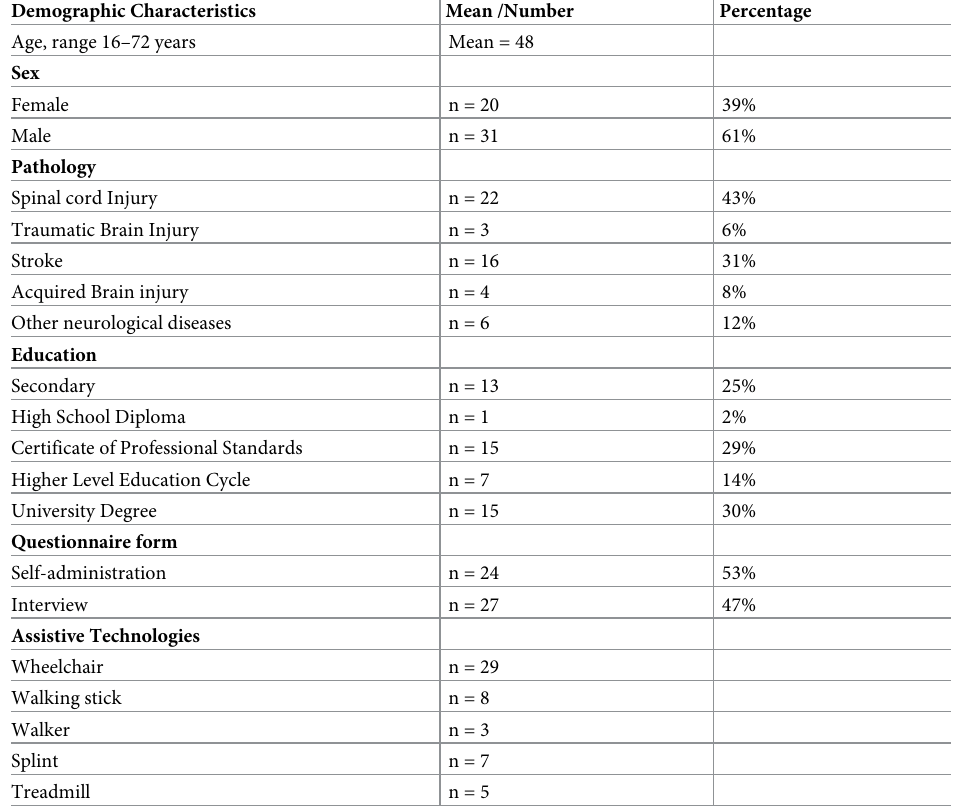
Table 6. Demographic characteristics of the 51 participants in the reliability and validity of NATU